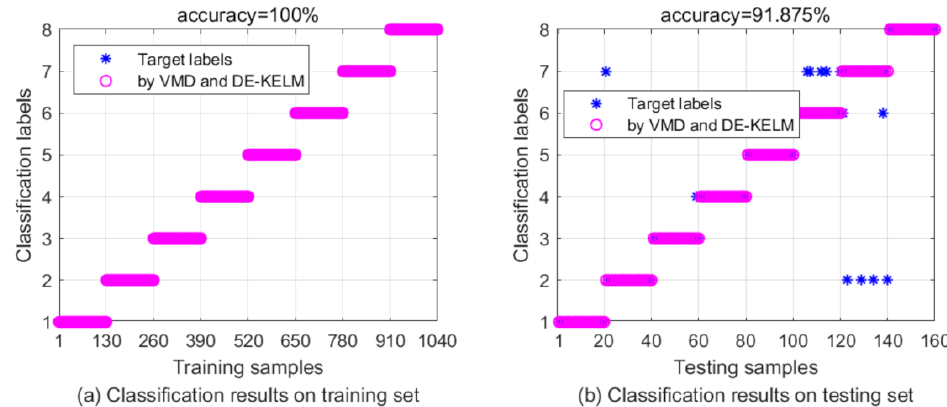
Figure 21. Fault classification results by DE-KELM on the feature matrix calculated through VMD- based decomposition method.